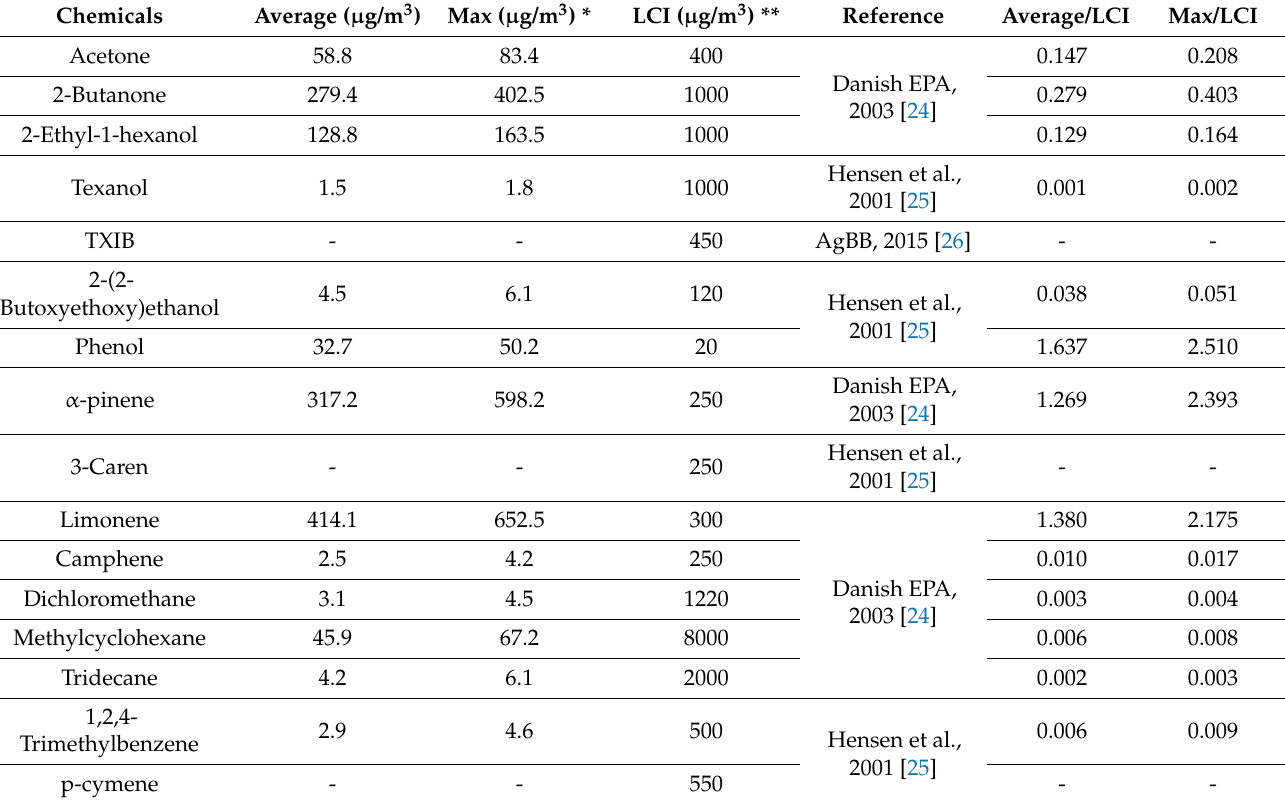
Table 4. Comparison between measurement results and LCI (lowest concentration of